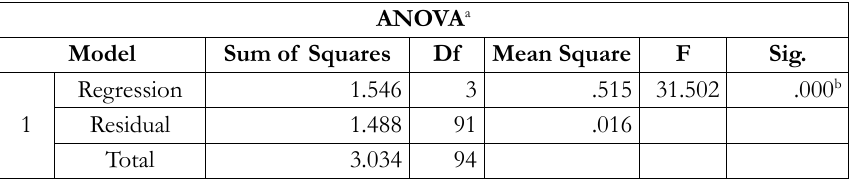
Table 8. Regression results of X1, X2 and X3 against Y